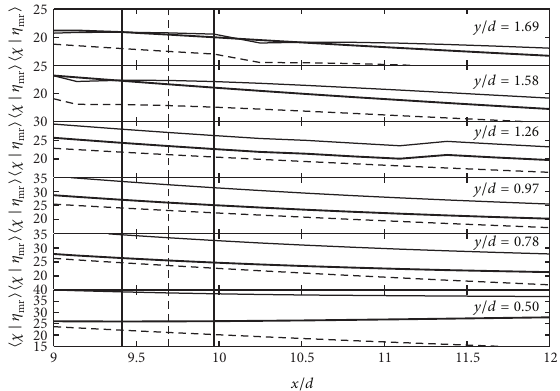
⟩ at several radial locations for Figure 4: Axial profiles of ⟨𝜒 | 𝜂 mr = 1045 K: dashed lines, Girimaji’s model ( ⟨𝜒 | 𝜂 ⟩ 𝑇 ); 𝑐 mr CMC - 𝛽 G thin solid lines, Mortensen’s model based on the 𝛽 -PDF ( ⟨𝜒 | ⟩ 𝜂 );thicksolidlines,Mortensen’smodelbasedonthePMF- mr CMC - 𝛽 M ⟩ ). The vertical lines designate the ignition PDF ( ⟨𝜒 | 𝜂 mr CMC - PMF locations obtained with each CSDR model. The pattern of each vertical line follows that of the corresponding